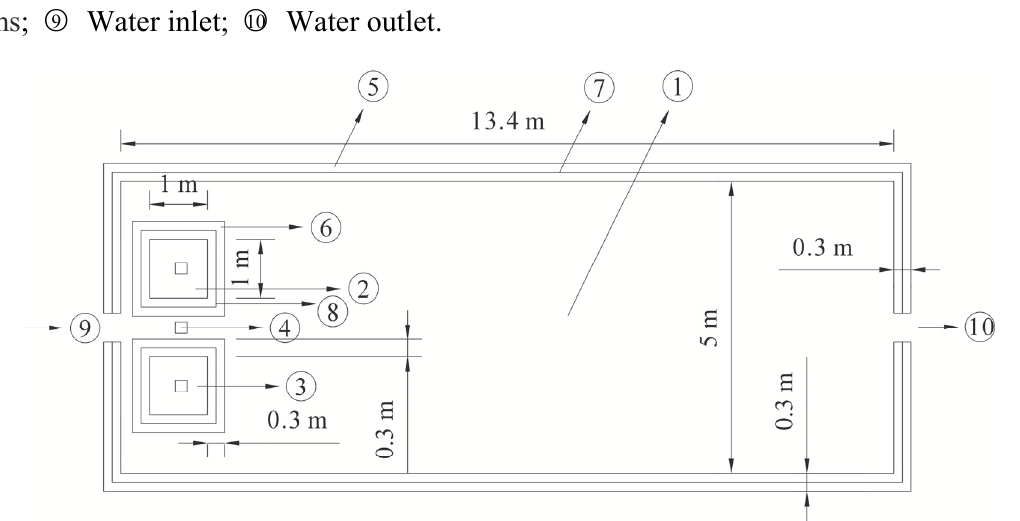
Figure 2. Schematic diagram of the experiment plot. ○ 1 Plot; ○ 2 Test pits with bottoms;